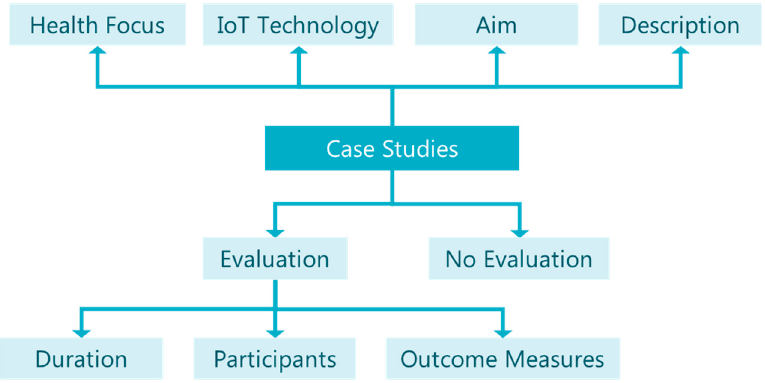
Figure 2. Case study classification taxonomy.